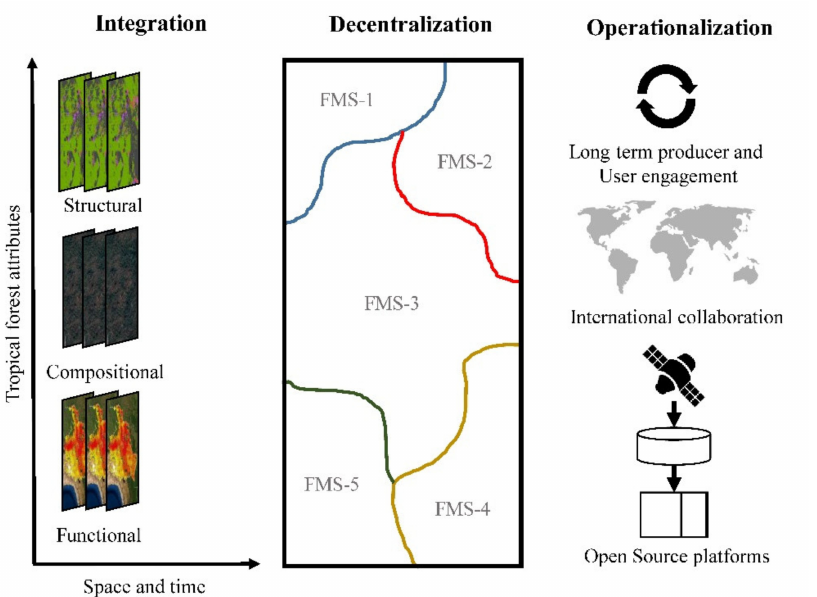
Figure 1. Schematic representation of key aspects in the design and implementation of effective and integrated tropical forest remote sensing systems as conceptualized in this paper: the integration of multiple data sources and techniques for mapping structural, functional, and compositional attributes; its decentralized implementation for adapting methods to local climatic and ecological characteristics and forest governance scales (FMS = forest monitoring system); and the operationalization of the system using all open-source computing platforms, leveraging international support in research and development and ensuring direct and constant user